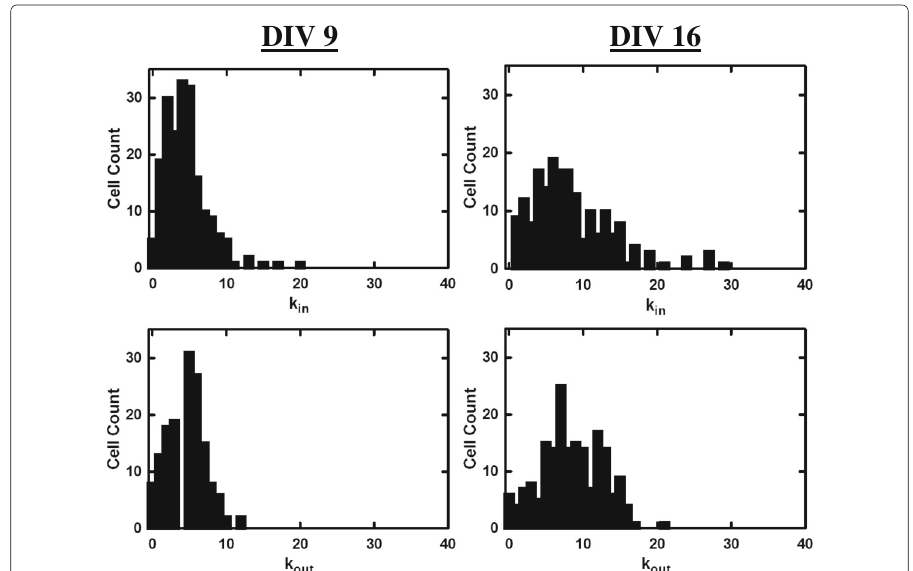
Fig. 5 Degree distributions of the same two networks shown in Fig.